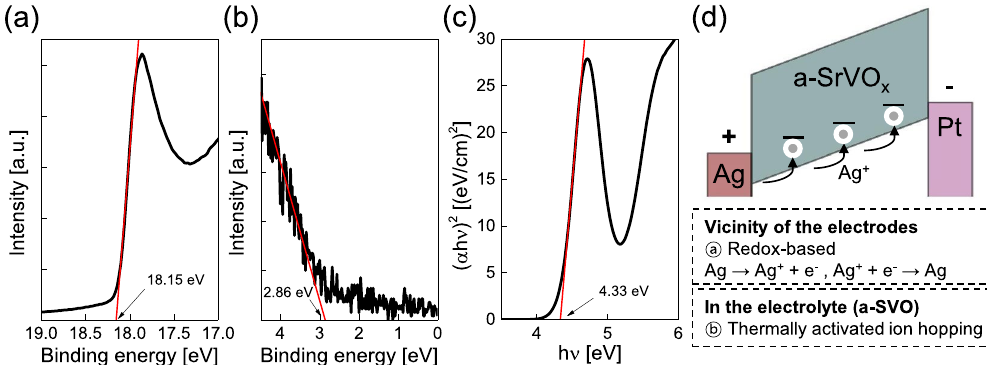
Figure 4. UPS analysis of an a-SVO film. ( a ) UPS SECO region and ( b ) valence band edge region of the a-SVO film. ( c ) Tauc plot from UV-Vis analysis of the a-SVO film. The red line represents the fitting line in the linear region. ( d ) Schematic energy band diagram of the Ag/a-SVO/Pt memristor under forward voltage bias. The conduction of Ag atoms is dominated by hopping from traps near the valence band edges of the a-SVO film, which is pinned by the electrodes. At the electrode/a-SVO interfaces, redox-based reactions occur, where Ag atoms are ionized into Ag + ions or the Ag + ions are reduced back to Ag atoms.